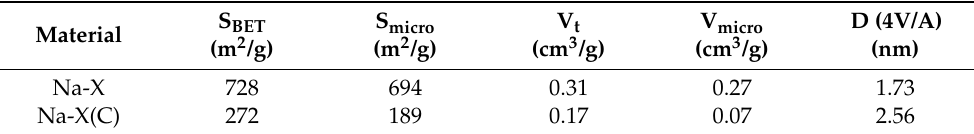
Table 1. Textural parameters of Na-X and Na-X(C) materials: S BET —specific surface area, S micro —